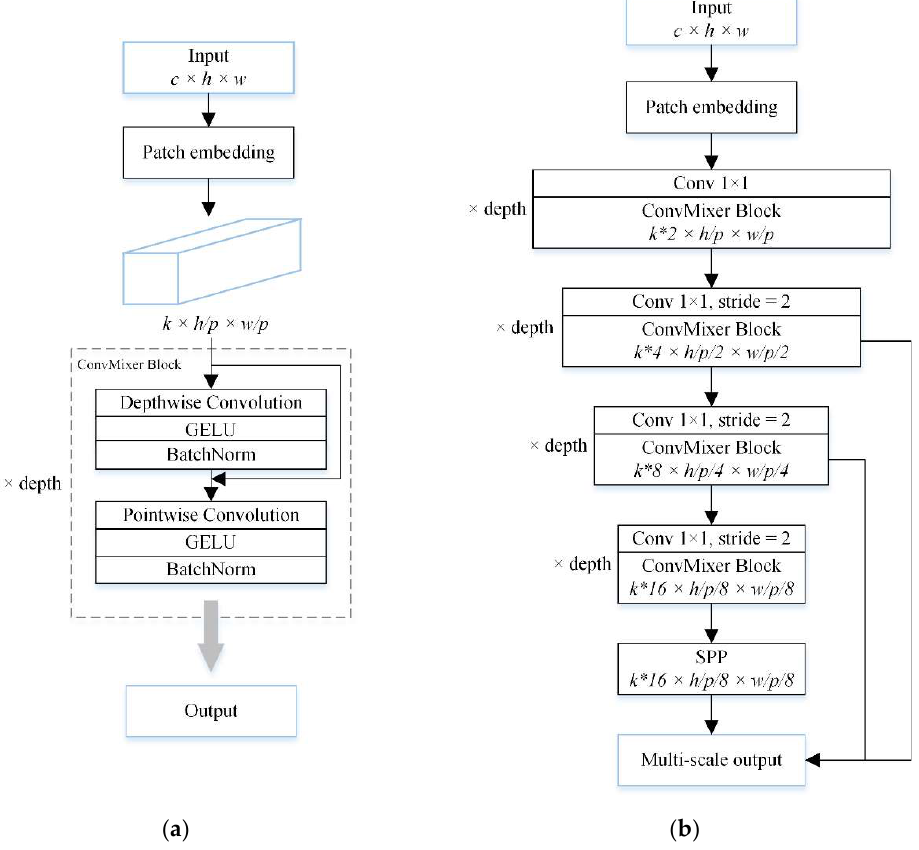
Figure 4. ( a ) The structure of ConvMixer. ( b ) The structure of the inverted pyramid ConvMixer net (ICPN). 249